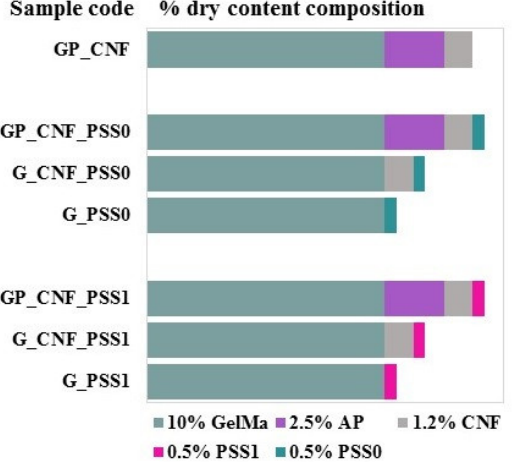
Figure 8. Schematic diagram depicting the nanocomposite hydrogel composition.